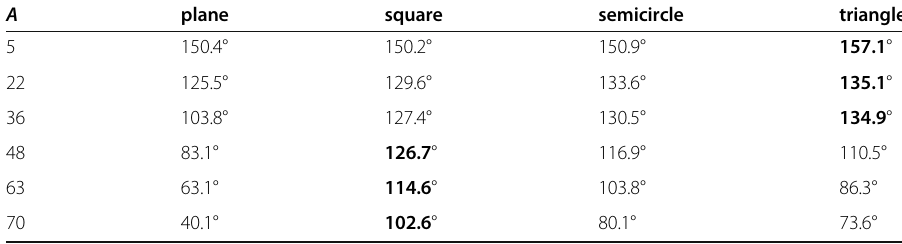
Table 3 Contact angles of 20ul droplets on surfaces of different microstructures A plane square semicircle